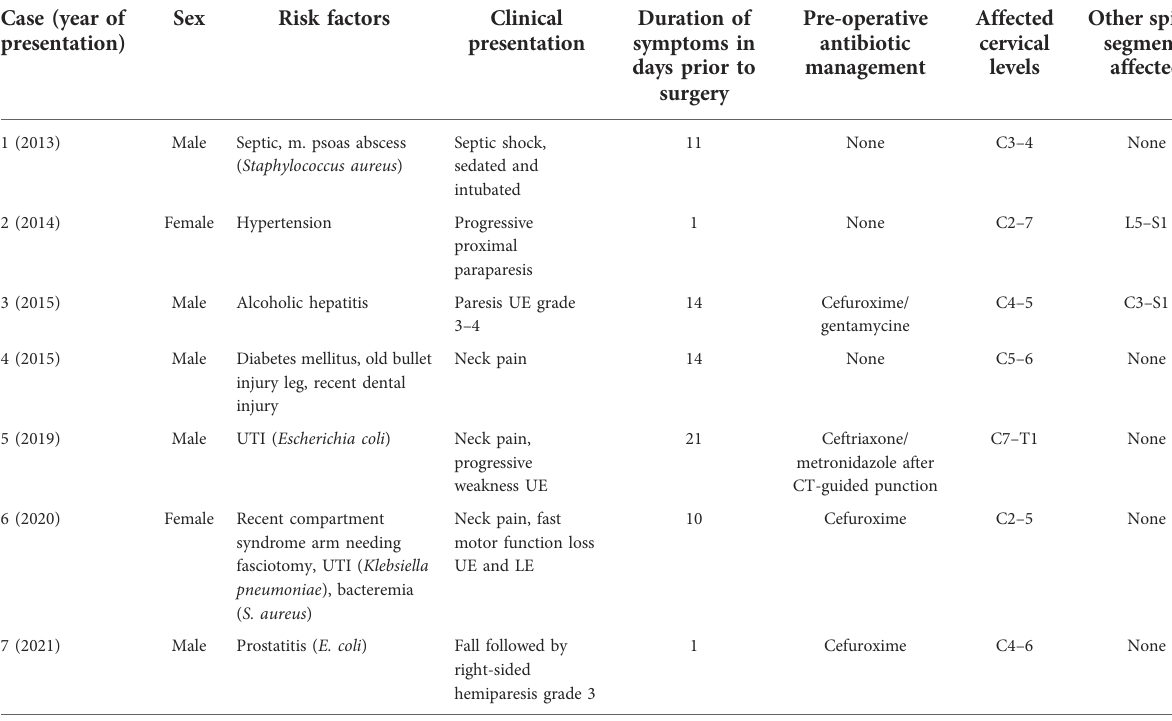
TABLE 1 Demographic data, comorbidities, duration of symptoms in days, affected cervical levels and co-affected spinal regions. Case (year of